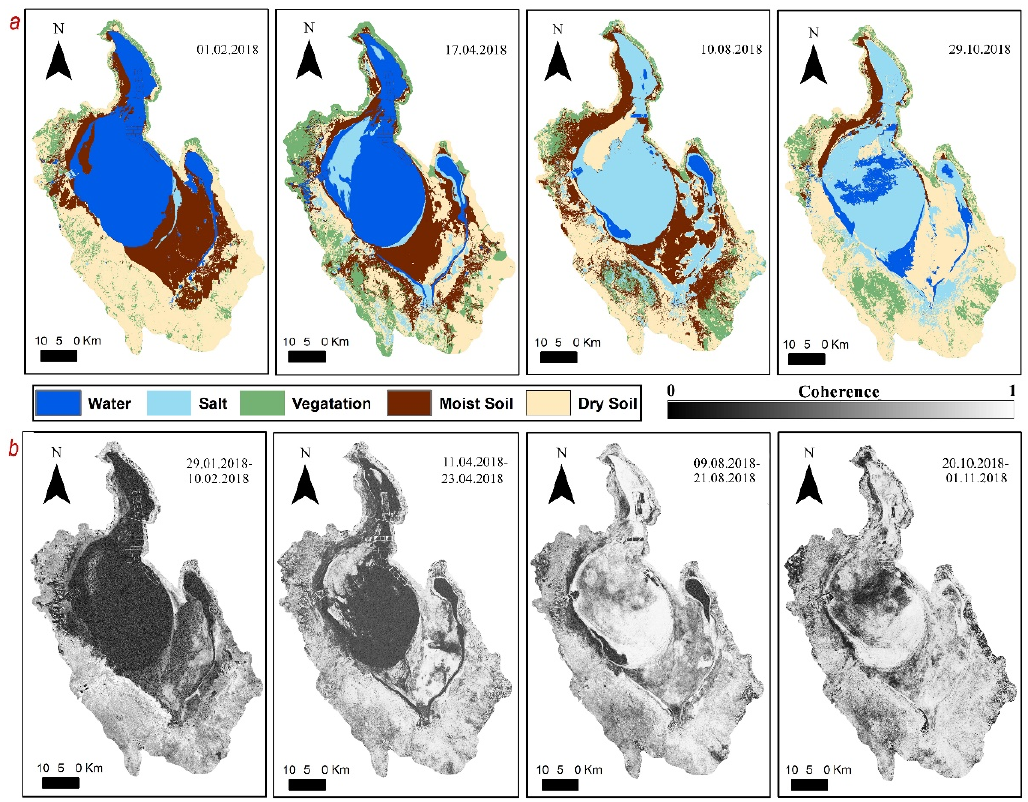
Figure 7. Sentinel-2 classified images and the corresponding Sentinel-1 coherence images derived from the seasonal data. Coherence maps of shortest time-based interferograms containing selected data. Coherence maps of shortest time-based interferograms containing selected Sentinel-2 Sentinel-2 images.